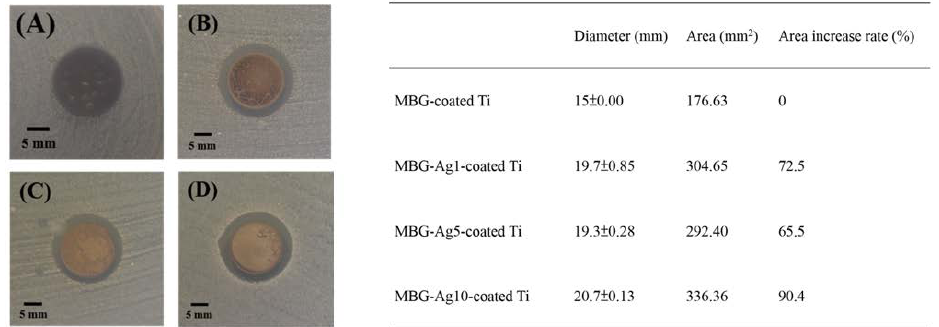
Figure 10. The inhibition zones of ( A ) MBG–coated Ti, ( B ) MBG–Ag1–coated Ti, ( C ) MBG–Ag5–coated Ti, and ( D ) MBG–Ag10–coated Ti against 10 7 CFU/mL Streptococcus mutans .